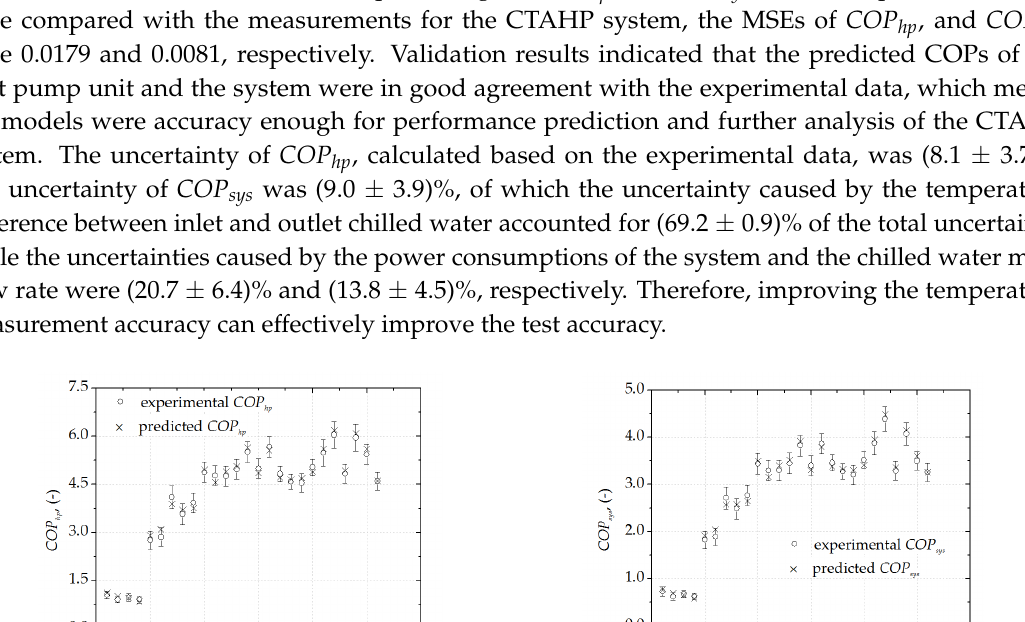
( f ) Figure 6. Normal probability plots of: ( a ) ambient wet-bulb temperature; ( b ) chilled water inlet temperature; ( c ) chilled water flow rate; ( d ) fan input power; ( e ) input power of condenser water pump and ( f ) compressor input power.